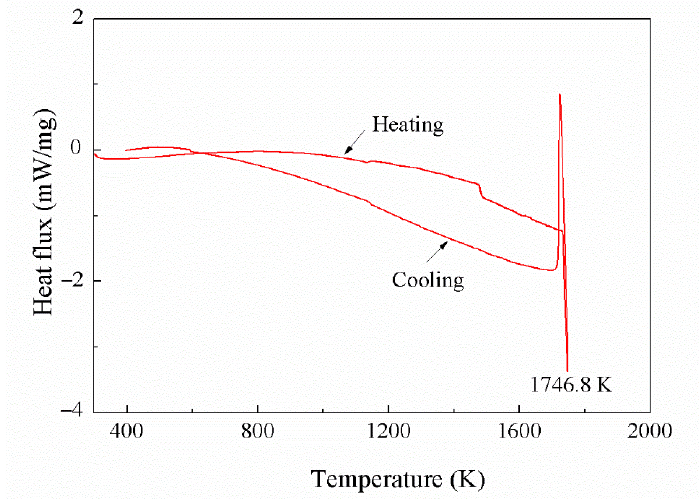
Figure 9. DSC curve of Co 50 Ni 40 Fe 10 alloy.